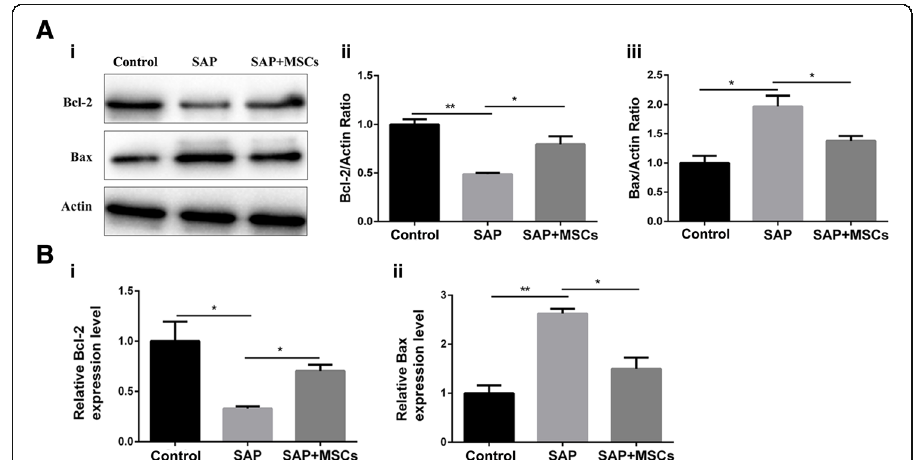
Fig. 6 MSCs upregulated Bcl-2 expression and downregulated Bax expression in the brains of SAP rats. a (i) Representative western blotting images of Bcl-2 and Bax protein expression in the brains of SAP rats. (ii) Statistical analysis of Bcl-2 protein expression based on a western blotting assay. (iii) Statistical analysis of Bax protein expression based on a western blotting assay. b (i) Results of a quantitative PCR assay for Bcl-2 gene expression in the brains of SAP rats. (ii) Results of a quantitative PCR assay for Bax gene expression in the brains of SAP rats. * p < 0.05, ** p <